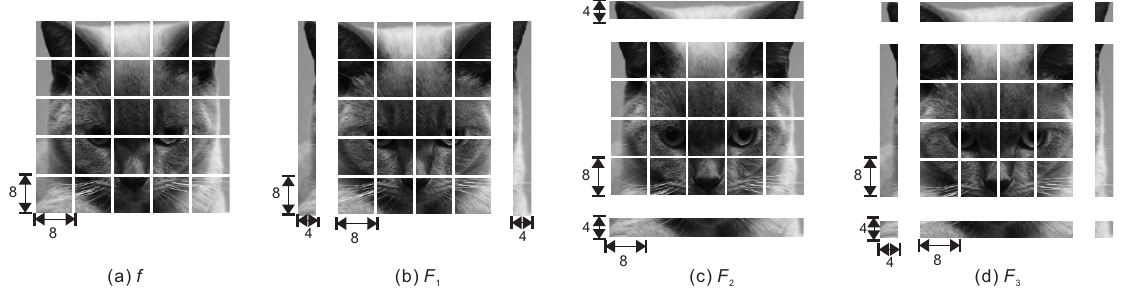
Figure 9. Illustration of different block partition methods: ( a ) the original “non-shifted” image f ; ( b ) the “horizontal shifted” image F 1 ; ( c ) the “vertical shifted” image F 2 ; and ( d ) the “diagonal shifted” image F 3